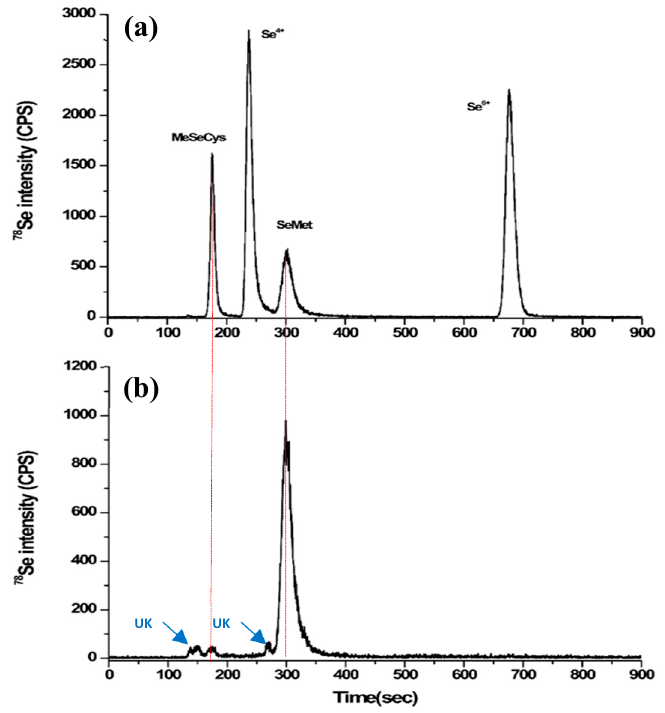
Figure 2. The cromatographic profiles of a standard selenium mixture ( a ) and enzymatically-extracted organic selenium from selenium-enriched B. bifidum BGN4 ( b ) analyzed by HPLC-ICP-MS. UK denotes unknown.